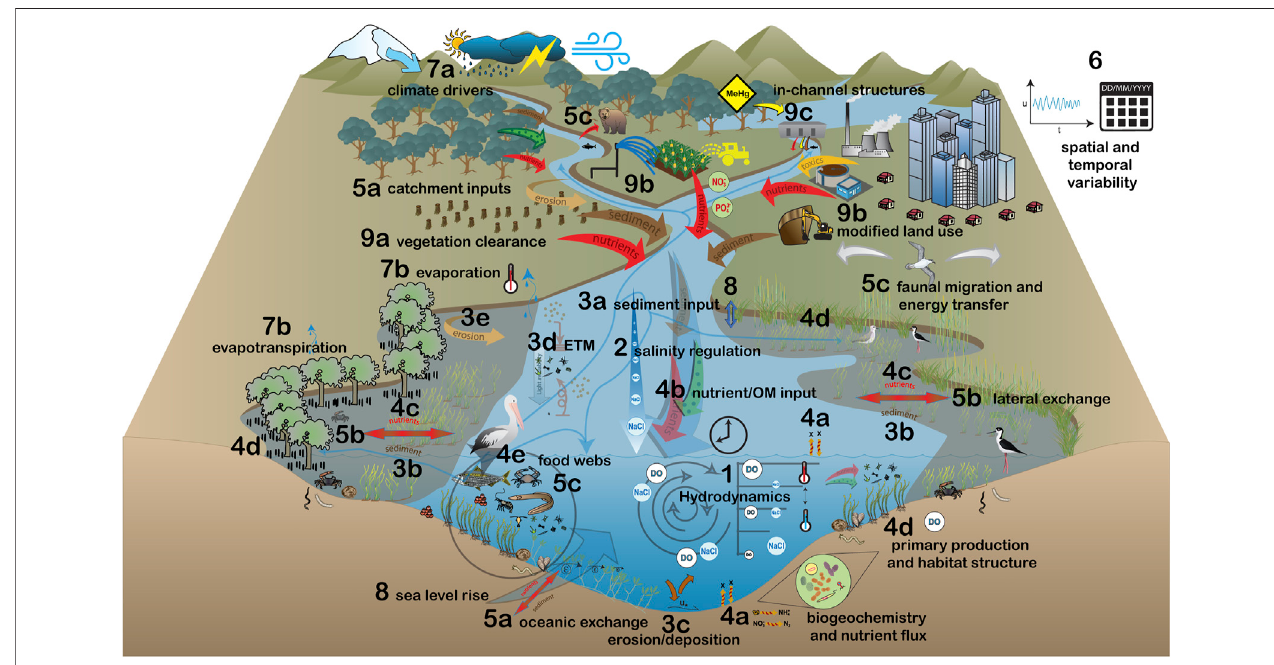
FIGURE 1 | Conceptual diagram demonstrating the in fl uences of freshwater fl ows on important estuarine ecosystem processes: 1) hydrodynamics, 2) salinity regulation,3a – e)sediment dynamics (a:catchmentsedimentinput,b:lateral sedimentexchange,c:mouth erosion/deposition, d:estuarineturbidity maximum (ETM),e: lateralerosion),4a – e)nutrientcyclingandtrophictransfer(a:biogeochemicalprocessing andexchange betweensediments,openwaterandatmosphere,b:catchment nutrient and organic matter (OM) inputs, c: lateral nutrient and energy exchange, d: primary production, e: food webs), and 5a – c) hydrological connectivity (a: longitudinal connectivity, b:lateral connectivity, c: energy transfer and faunalmigrations), 6) spatial and temporal variability,and the drivers which changethe in fl uenceof freshwater fl ows upon the ecosystem processes: 7a-b) climate (a: rainfall, temperature, snowmelt, storms and droughts, b: evaporation and evapotranspiration, 8) sea level rise and 9a – c) direct anthropogenic drivers (a: vegetation clearance, b: land use modi fi cation, c: in-channel